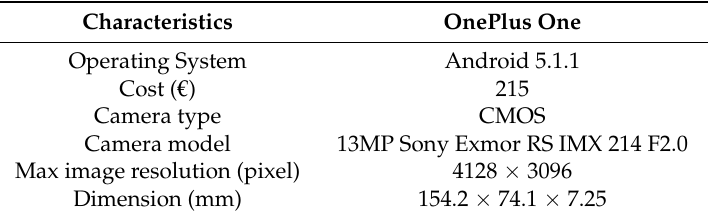
Table 2. Smartphone